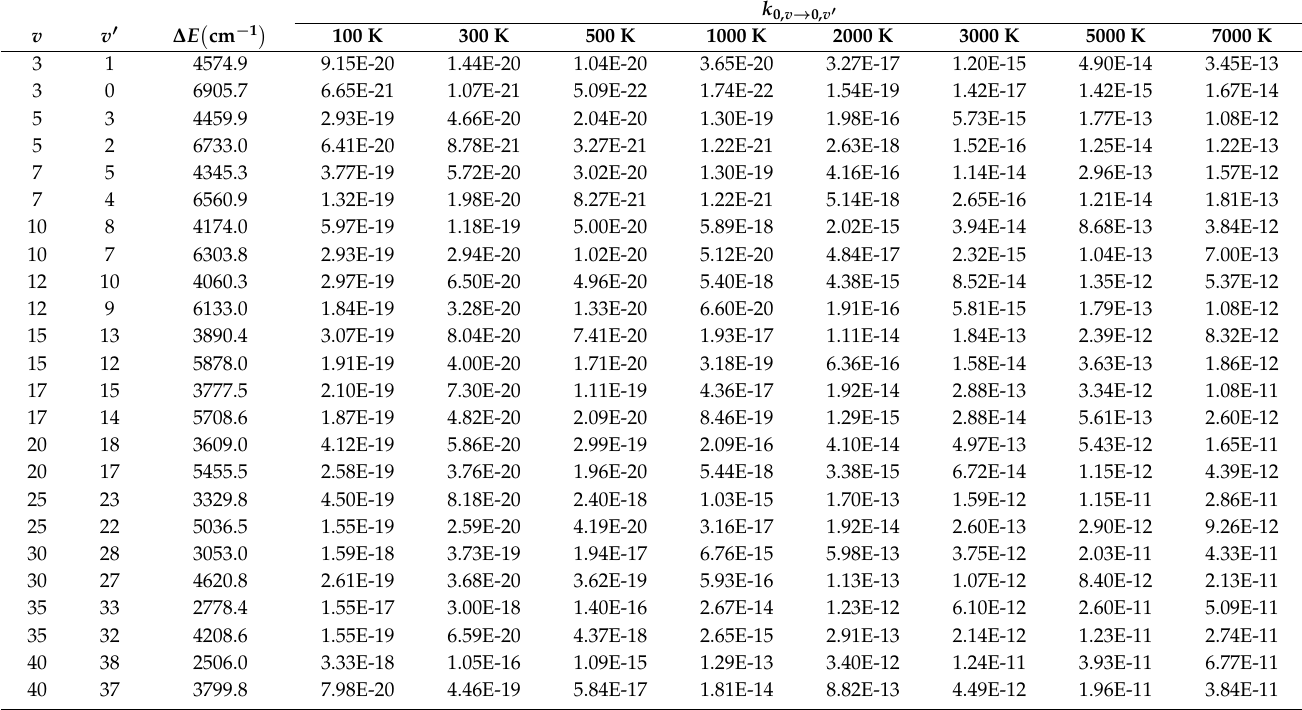
Table 11. Multiquantum V–T/R rate coefficients (in cm 3 /s) for the transition CO ( 0 ) + N 2 ( v ) → CO ( 0 ) + N 2 ( v (cid:48) ) + ∆ E